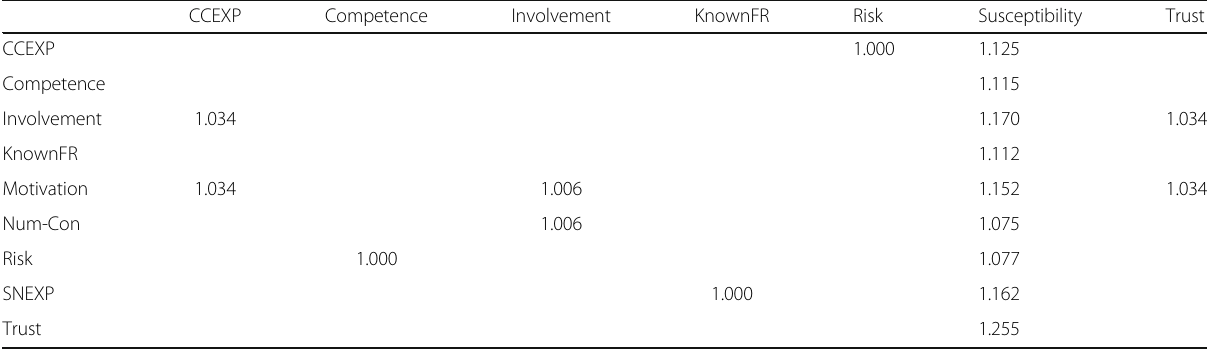
Table 3 Collinearity assessment